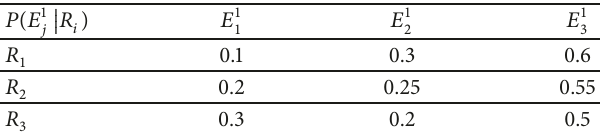
Table 5: The relationship between alternative plans and new